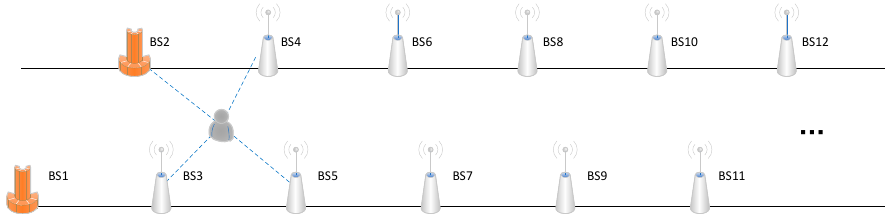
Figure 11. Location estimation process of the tag.